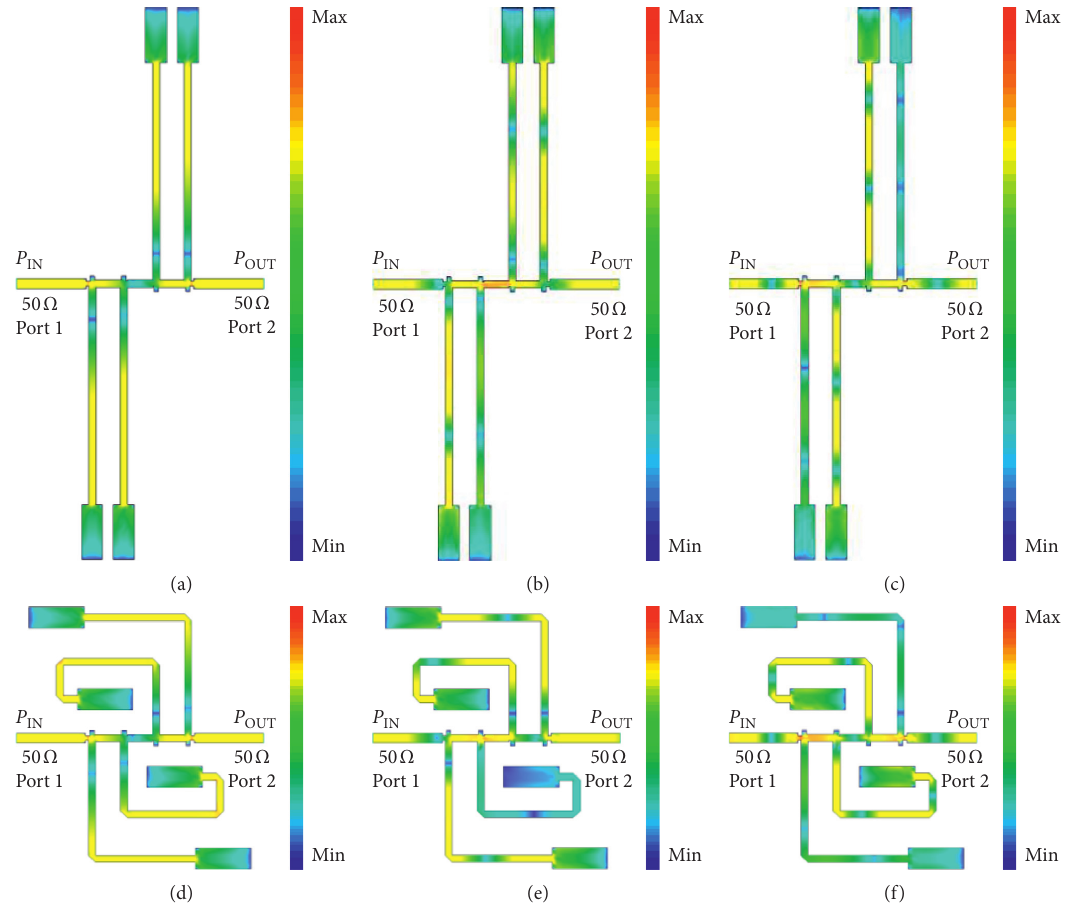
Figure 14: Surface current flow of a QC-SSIR at (a) f 1 , (b) f 2 , and (c) f 3 and an FQC-SSIR at (d) f 1 , (e) f 2 , and (f) f 3 . Table 1: Summary of the proposed multiwideband BPF comparison.